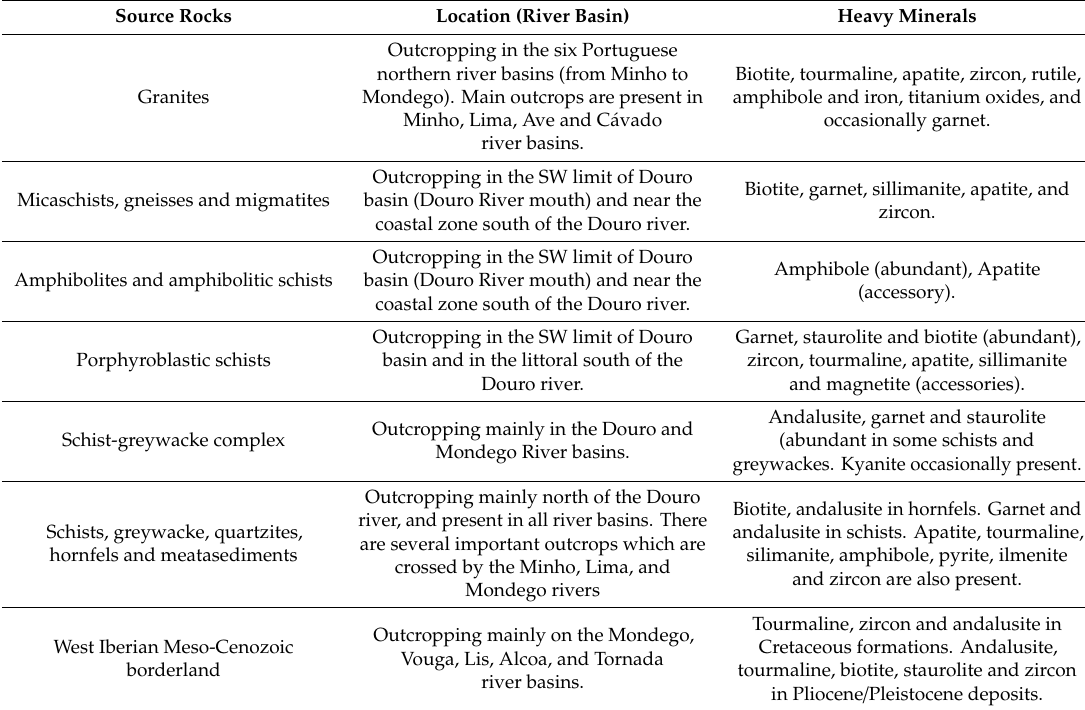
Table 1. Heavy mineral composition of the main igneous and metamorphic rocks and from the sedimentary rocks from the West Iberian Meso-Cenozoic borderland. These geological formations are present in the Portuguese north and western river basins (based on the information contained in works